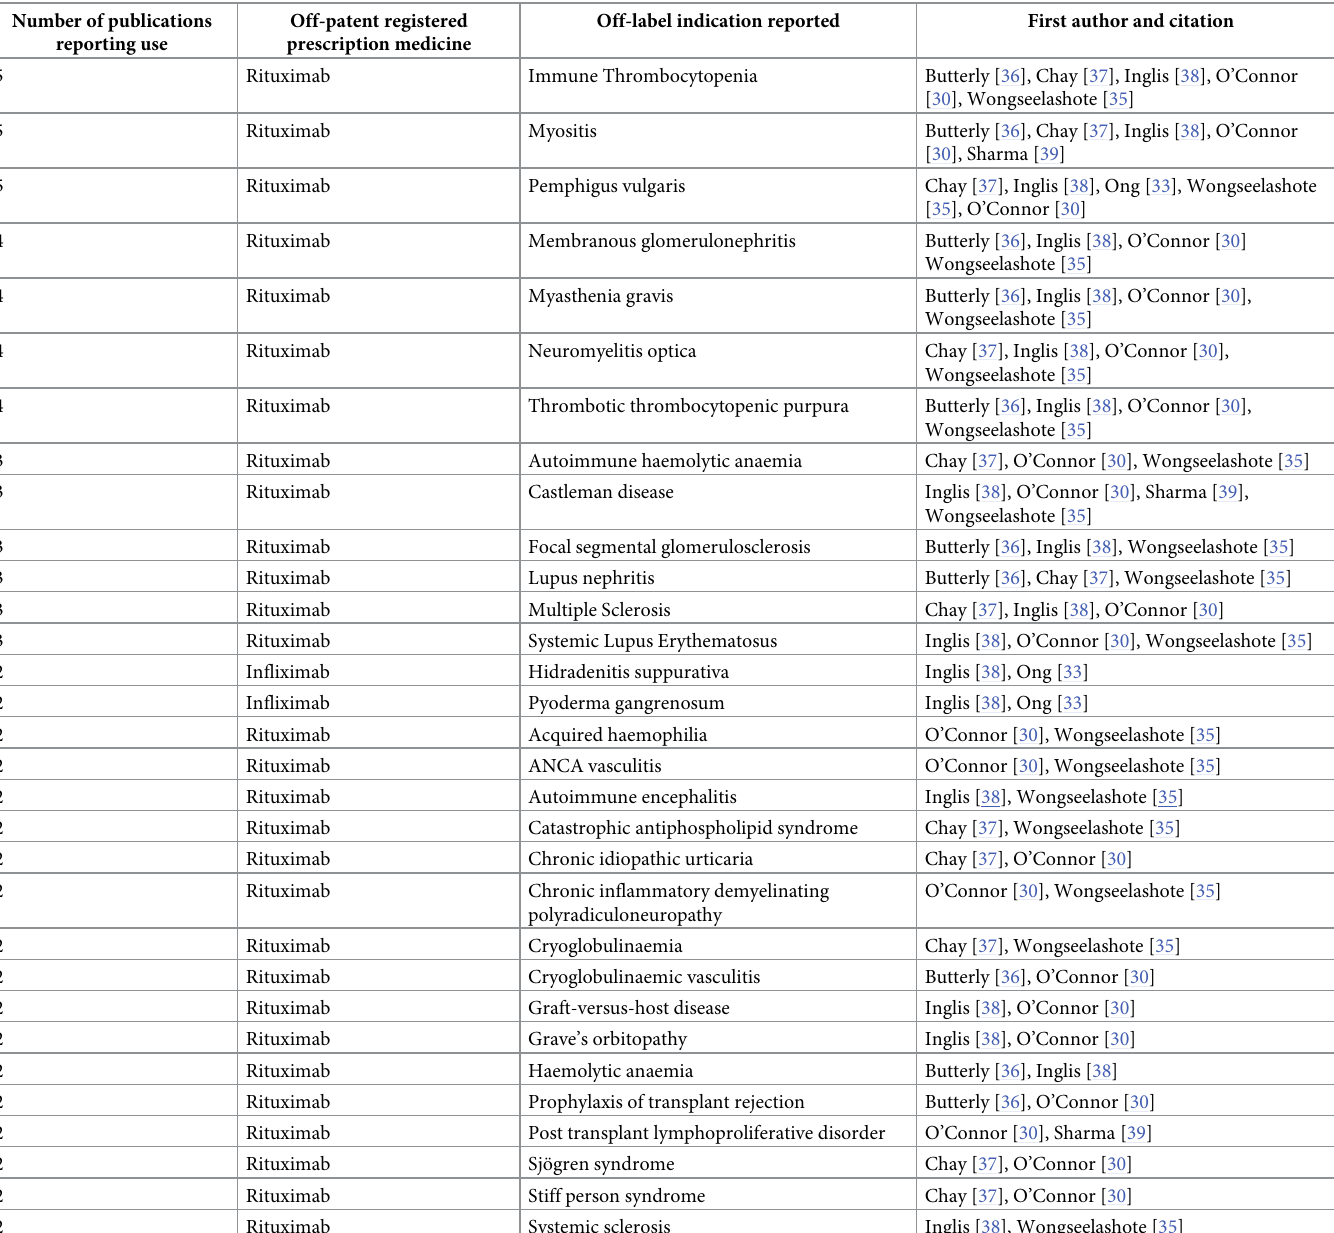
Table 5. Off-patent registered prescription medication/off-label indication dyads reported more than once in the literature. Number of publications reporting